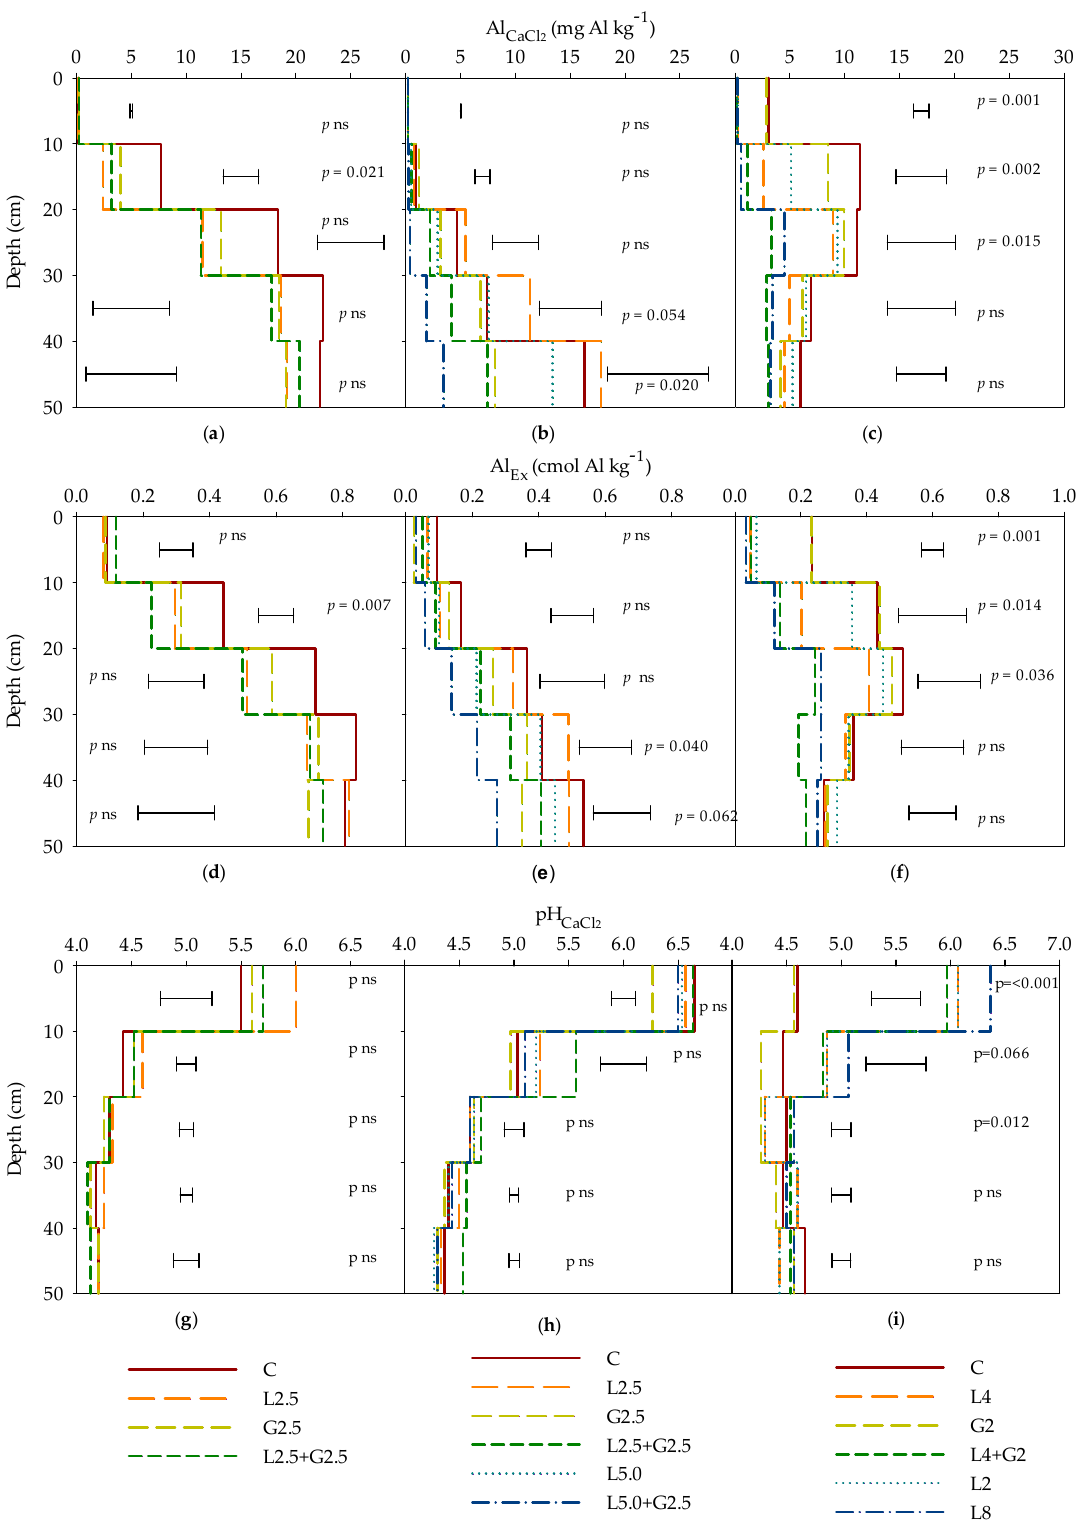
Figure 2. ( a – c ) Soil Al CaCl 2 , ( d – f ) Al Ex , and ( g – i ) pH CaCl 2 ( a , d , g ) in the ST for C, L2.5, G2.5, L2.5 + G2.5 treatements ( b , e , h ), in the MT for C, L2.5, G2.5, L2.5 + G2.5, L5.0, and L5.0 + G2.5 treatments; and ( c , f , i ) and in the LT for C, L4, G2, L4 + G2, L2, and L8 treatments. Error bars represent least significant difference values at p = 0.05, n = 3 for each depth with ns denoting p > 0.05. The exceptions were in ( e ) for the 40–50 cm where p = 0.062 and ( i ) for the 10–20 cm where p =